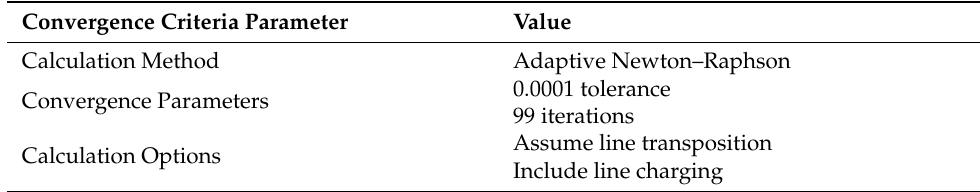
Table 3. Data for load flow simulation convergence criteria.